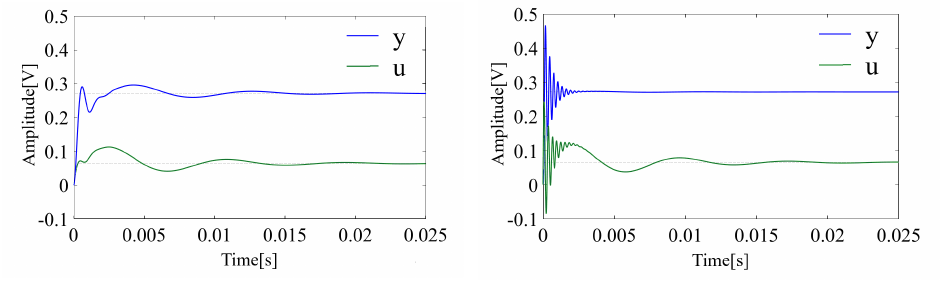
Figure 4. Step response of the analog